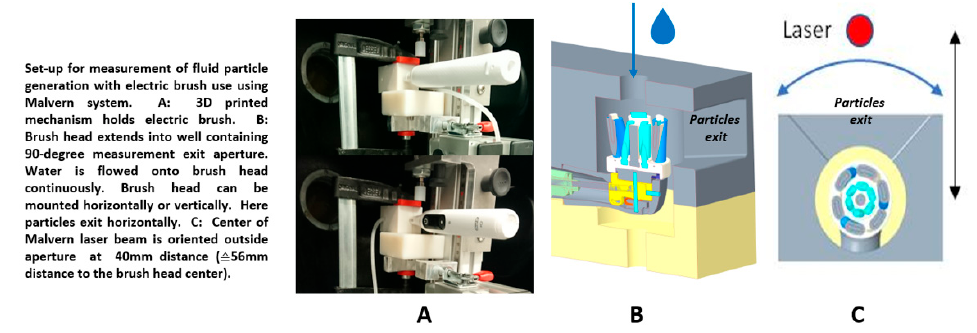
Figure 1. Schematic of Malvern system experimental setup.